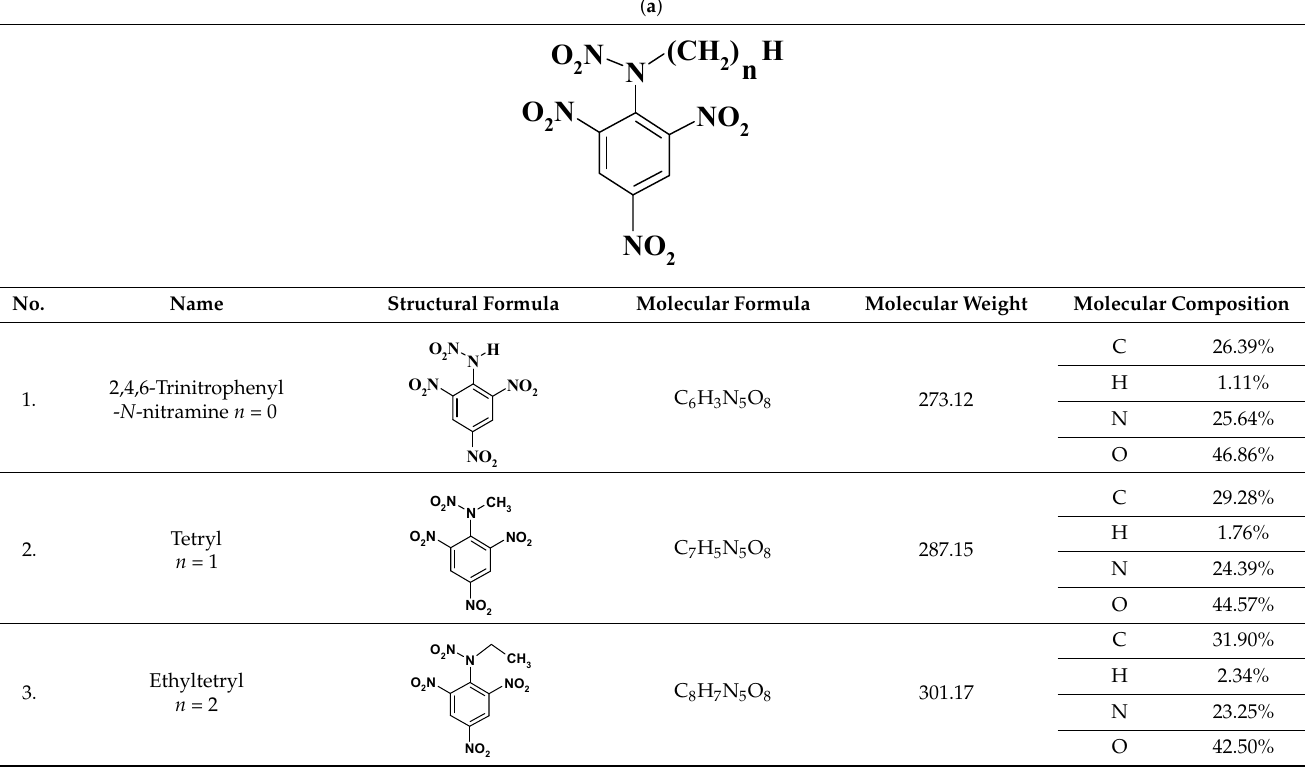
Table A2. The view of the molecules belonging to ( a ) Homologous aromatic N -nitramines, tetryl derivatives [(2,4,6-trinitrophenyl-(O 2 N)N(CH 2 ) n H, n = 0–5]. ( b ) Bis-aromatic homologs of chain length variation (CH 2 ) n of [(2,4,6-trinitrophenyl-N(NO 2 )] 2 , (CH 2 ) n ( n = 1–5)]. ( c ) 3-Amino derivatives of tetryl with chain length variation [(3-amino-2,4,6-trinitrophenyl-(O 2 N)N(CH 2 ) n H, n = 1–5] homologs. their names, structures, chemical compositions and molecular weights (g/mol).